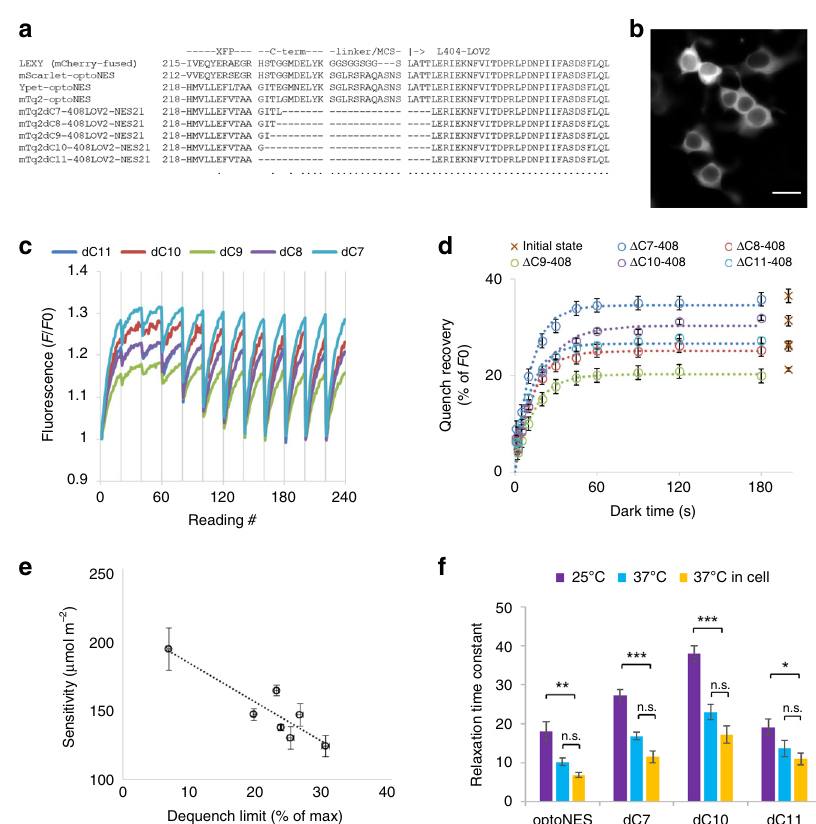
Fig. 4 Increased RET to LOV2 and sensitisation can be achieved by linker optimisation. a Alignments of XFP-optoNES variants compared with the original mCherry-fused LEXY 9 , showing the end of the fl uorescent protein β barrel and intervening sequences. As LOV2 starts at leucine 404 or trimmed